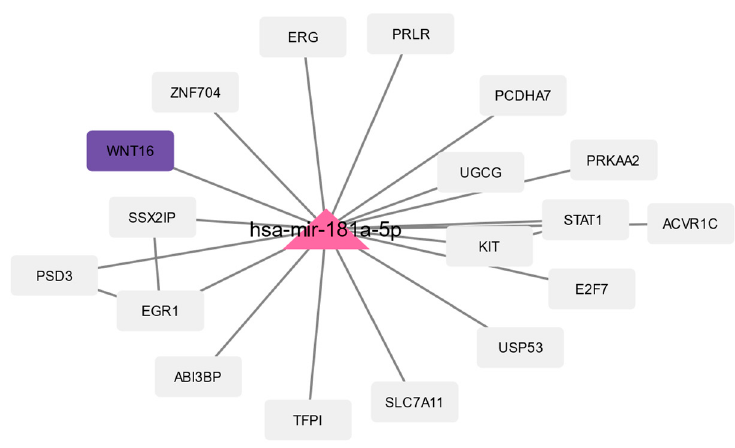
Figure 7. miRNA prediction and network visualization of miRNAs related to WNT16. Predicted miRNA interaction partners of hsa-mir-181a-5p, WNT16 is highlighted.